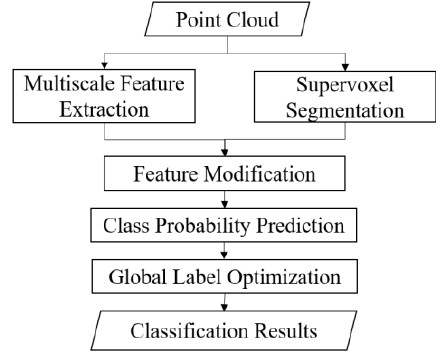
Figure 1. Flowchart of the proposed SegMSF method.